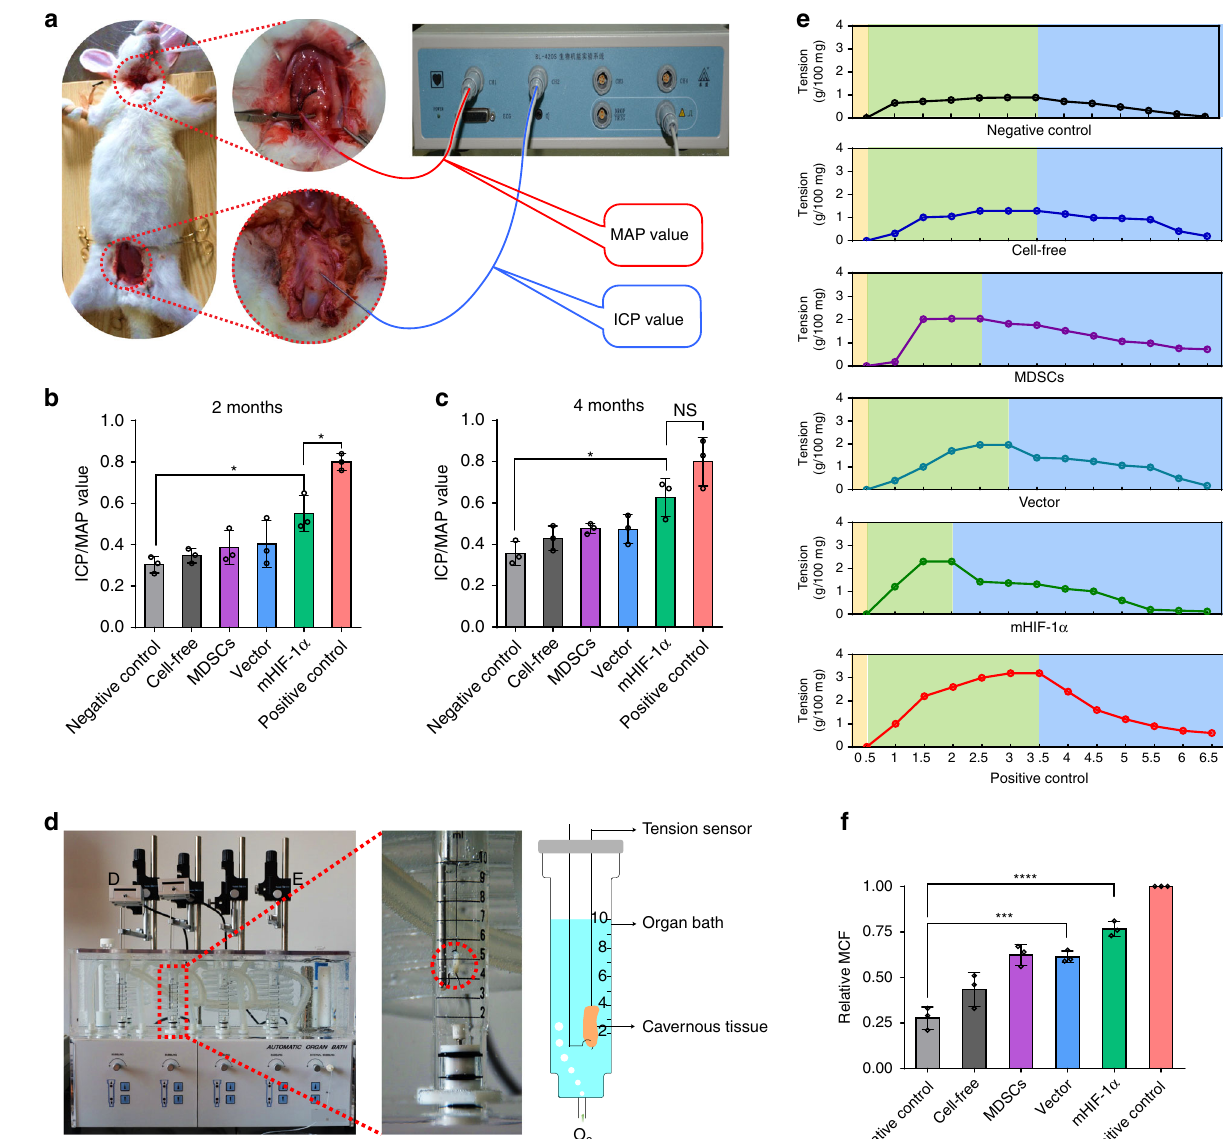
Fig. 6 Detection of intracavernosal pressures (ICP) and mean arterial pressure (MAP) and organ bath testing in the repaired cavernosa. a The diagram of measurement method of ICP and MAP. b , c After 6 V of electrical stimulation was applied to the cavernous nerve, the ICP/MAP value was recorded in six different groups after 2 ( b ) and 4 ( c ) months of implantation ( n = 3). Data are displayed as mean ± SD and analysed by two-way ANOVA with Sidak's multiple comparisons test in b (mHIF-1 α vs Negative control: * P = 0.0482; positive control vs mHIF-1 α : * P = 0.0215) and c (* P = 0.0276; NS, p > 0.05). d Images and schematic diagram showing organ bath testing of contraction force of repaired cavernosa at 37 °C, 95% oxygen and 5% carbon dioxide. The cavernous tissue (in the red dashed circles) was incubated in the Krebs solution and its contraction force was measured by a tension sensor under the constant oxygen fl ow. e Oscillogram of tension change by phenylephrine (green area) and phentolamine (blue area) stimulation of the repaired corpus cavernosum in each group (negative control, cell-free, MDSCs, vector and mHIF-1 α or positive control group) after 4 months of implantation ( n = 3). f Relative maximum contraction force (MCF) in fi ve implantation groups (negative control, cell-free, MDSCs, vector and mHIF-1 α groups) compared with that in the positive control group (mean MCF is de fi ned as 1) after 4 months of implantation ( n = 3). (Sidak's multiple comparisons test, two-way ANOVA, *** p = 0.0004; **** p < 0.0001). Data are displayed as mean ± SD and analysed by GraphPad Prism